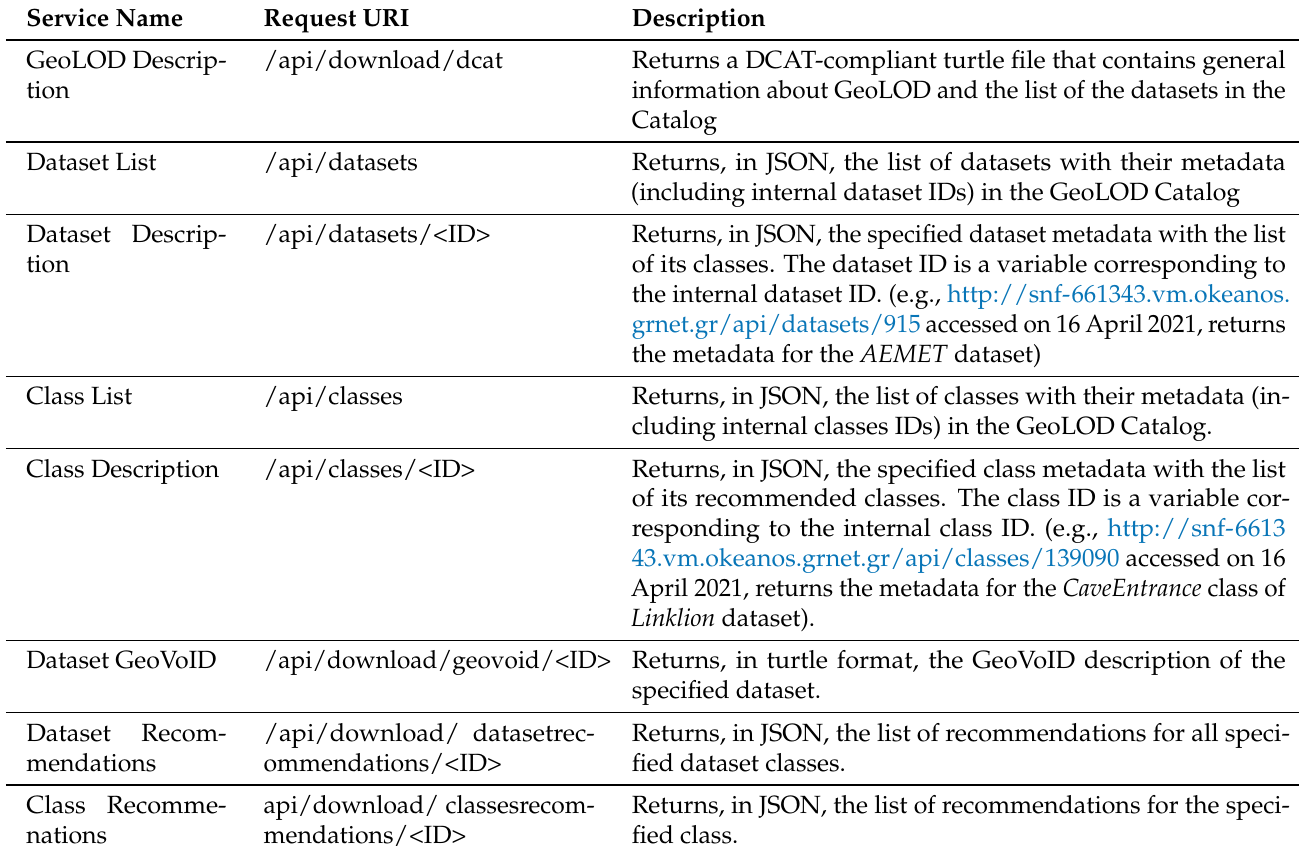
Table 2. GeoLOD REST